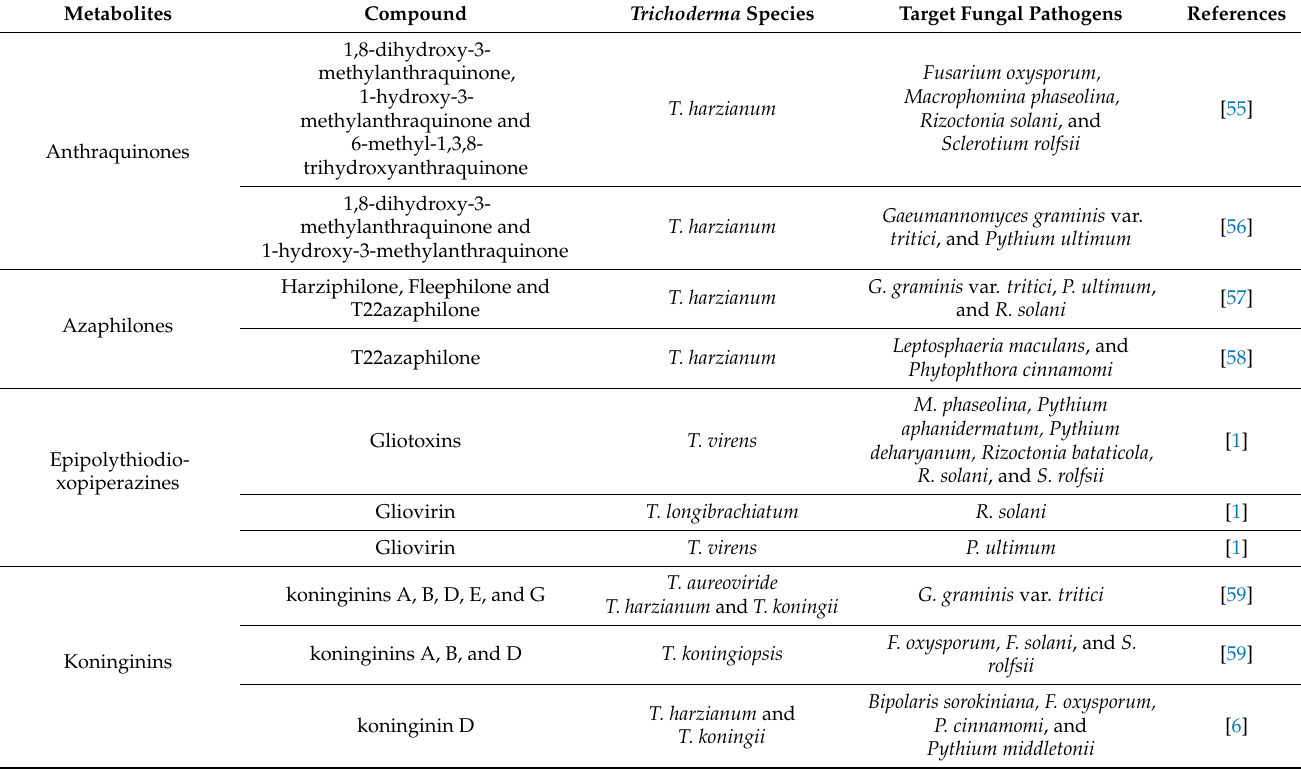
Figure 1. Metabolites (antibiotics and enzymes) produced by Trichoderma induce plant defense responses against the pathogens: (A) Trichoderma released antibiotics, enzymes, and secondary metabolites (SMs) through metabolic pathways leading to antagonize the phytopathogens. (B) Signals involved in Trichoderma –plant interaction enhanced the plant defense responses. Table 2. A list of metabolites and chemical compounds secreted by Trichoderma species affects soil pathogenic fungi.